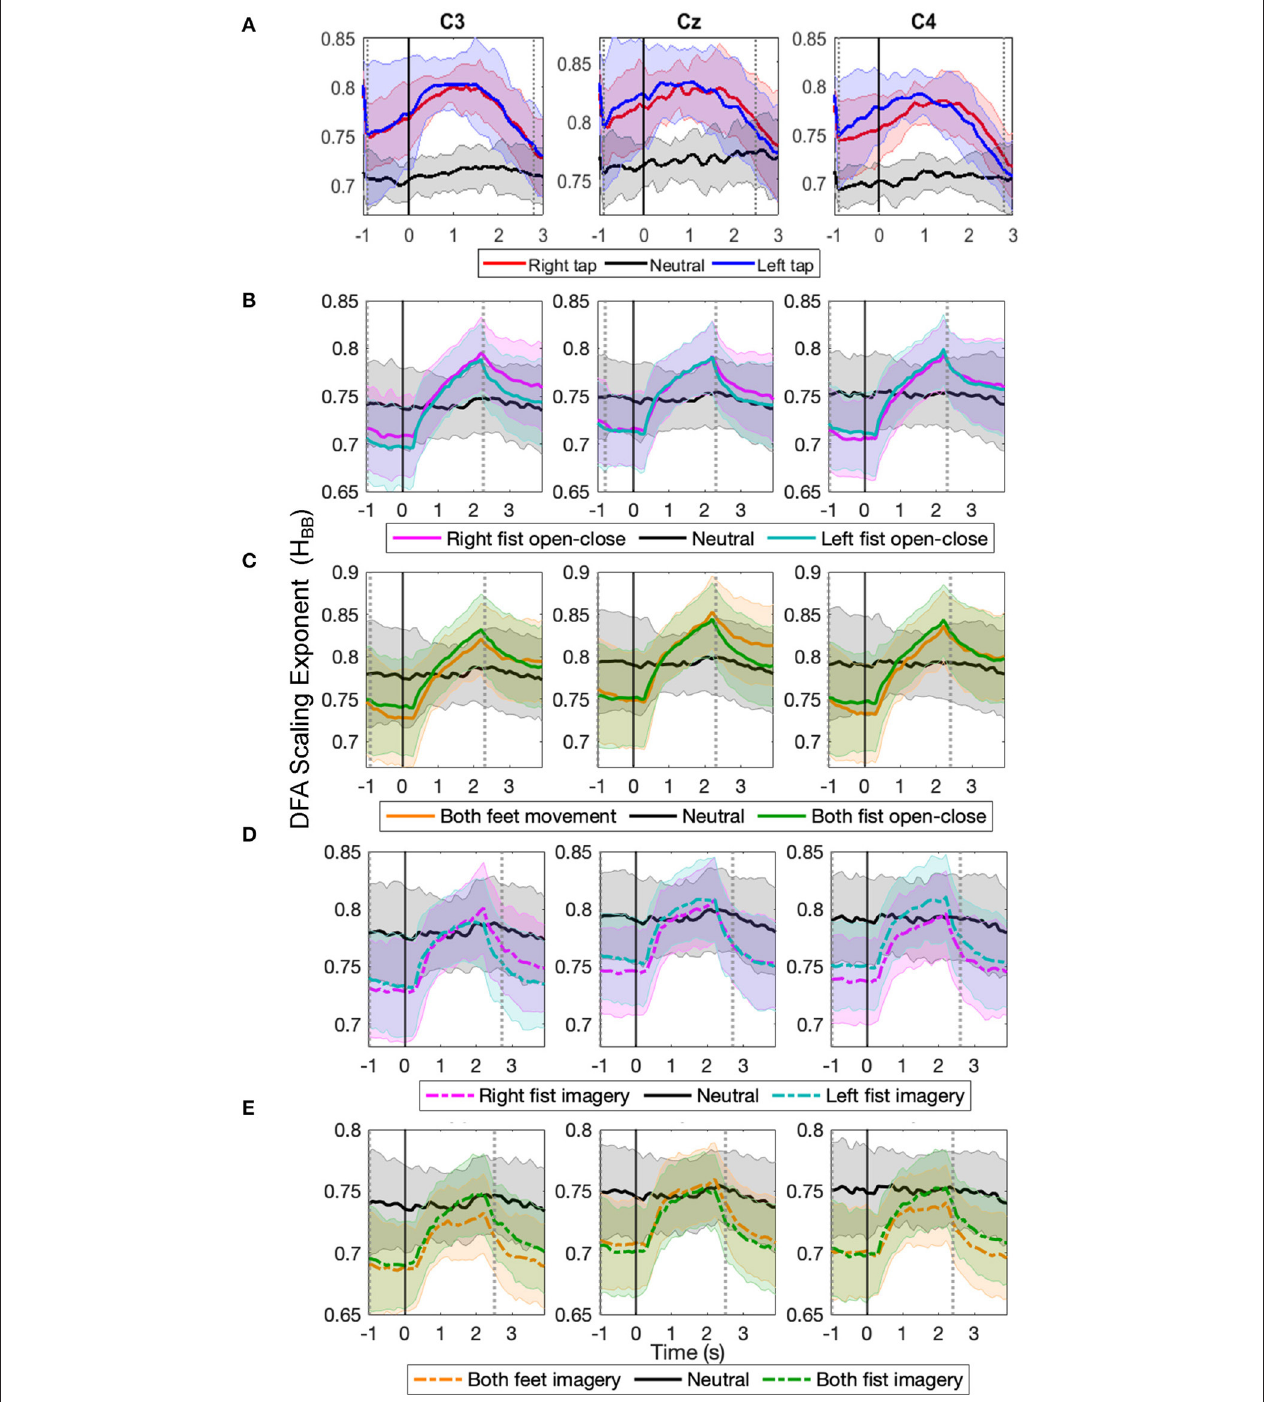
FIGURE 4 | The time evolution of grand average detrended fluctuation analysis (DFA) scaling exponents in broadband stitched electroencephalography (EEG) ( H BB ) in C3, Cz, and C4 during different movement and motor imagery tasks. The progression of the grand average of broadband DFA scaling exponent H BB from stitched EEG segments of all participants during (A) single asynchronous right (red) and left (blue) finger tap and resting state (black), (B) continuous right (magenta) and left (cyan) fist open-close movement, (C) continuous both feet (orange) and both fist (green) open-close movement, (D) motor imagery of continuous right (dashed magenta) and left (dashed cyan) fist open-close, (E) motor imagery of continuous both feet (dashed orange) and both fist (dashed green) open-close. Shaded areas show the standard deviation. Solid vertical line at 0 s marks finger tap onset in (A) and motor task cue in (B–E) . Dotted gray vertical lines show the period in which H BB of motor task trials is significantly different ( p < 0.05, Mann–Whitney U -test) from that of resting state trials. The H BB shows clear increase during all motor tasks.